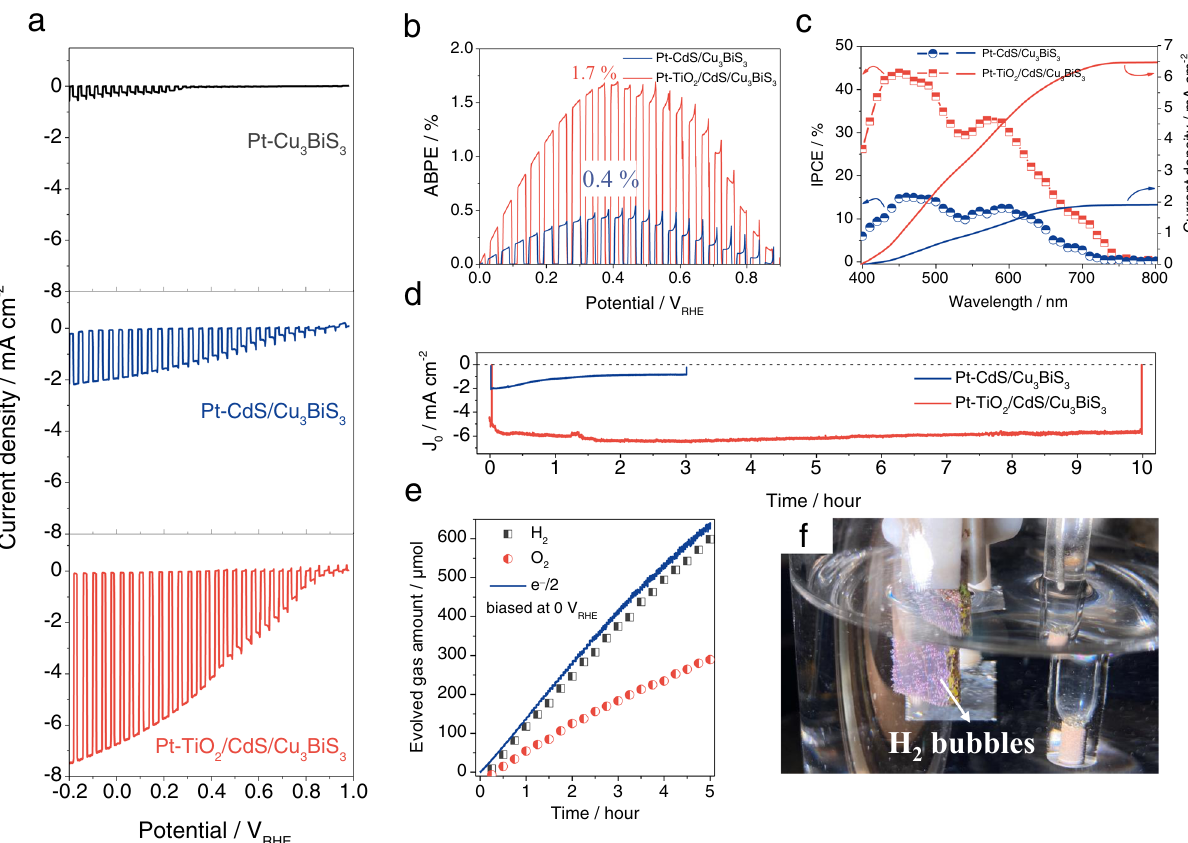
Fig. 3 PEC performance of the Cu 3 BiS 3 -based photocathodes. ( a ) Chopped photocurrent density-potential curves of the Pt-Cu 3 BiS 3 , Pt-CdS/Cu 3 BiS 3 and Pt-TiO 2 /CdS/Cu 3 BiS 3 photocathodes. ( b ) ABPE curves, ( c ) IPCE spectra and ( d ) photocurrent density-time curves of the Pt-CdS/Cu 3 BiS 3 and Pt-TiO 2 / CdS/Cu 3 BiS 3 photocathodes. ( e ) Hydrogen and oxygen evolution amounts of the Pt-TiO 2 /CdS/Cu 3 BiS 3 photocathode with various illumination times and ( f ) photograph of the Pt-TiO 2 /CdS/Cu 3 BiS 3 photocathode under working conditions. All measurements were carried out in a 0.2 mol/dm 3 Na 2 HPO 4 / NaH 2 PO 4 solution (pH = 6.5) under solar simulated AM 1.5 G light irradiation. Source data are provided as a Source Data fi